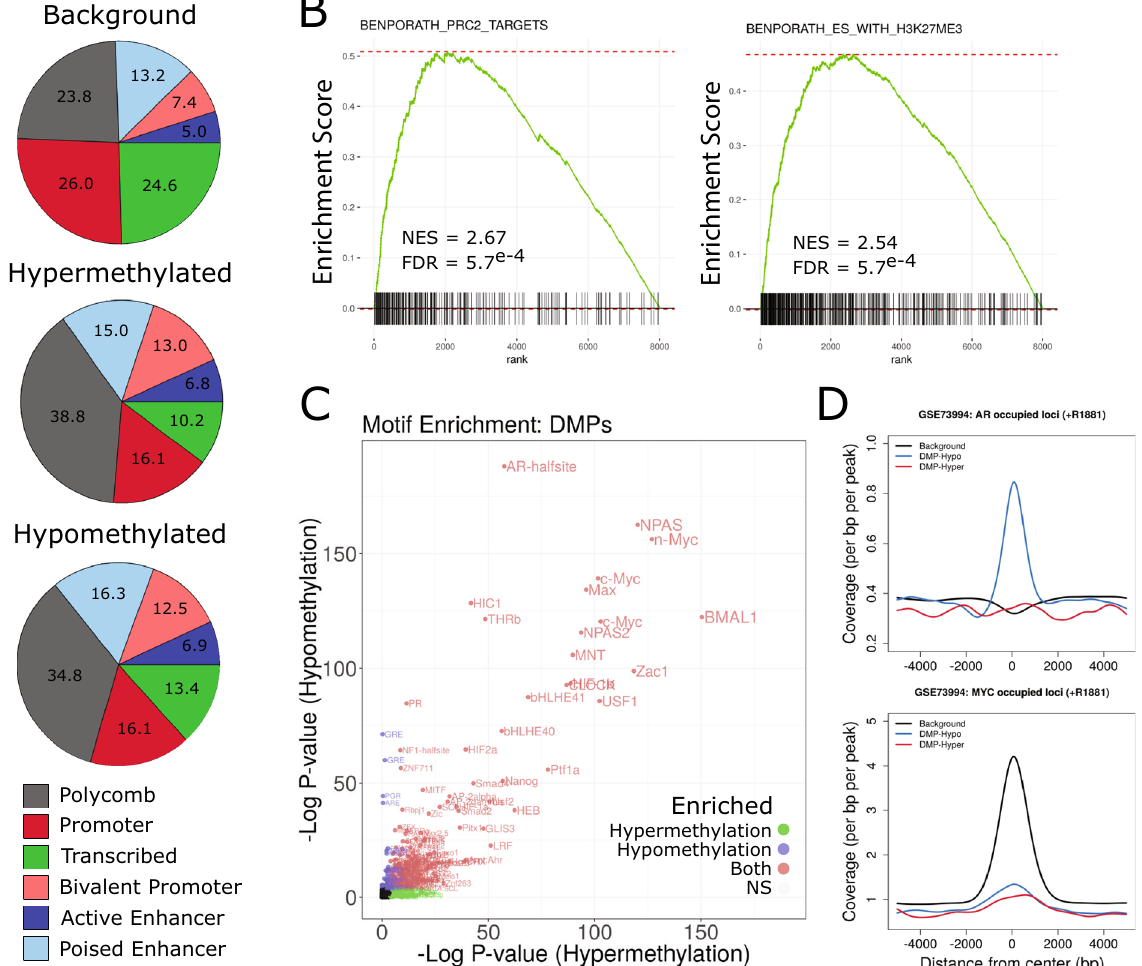
Figure 3. Dynamic methylation enriches for specific functional genomic loci and transcription factor binding. ( A ) Relative distributions of background and DMP sites to chromHMM identified regions observed in PrEC cells 13 . ( B ) Enrichment plots showing representative gene sets of Polycomb complex and H3K27me3 regulation pathways, two of the most frequently observed groupings from GSEA of dynamic methylation associated genes (Supplementary Fig. S3). ( C ) Motif enrichment was assessed at DMP positions (relative to background regions) using HOMER. ( D ) DNA binding profiles for AR and MYC in the presence of androgen were obtained (GSE73994) and enrichment at background CpG and DMP centered loci were